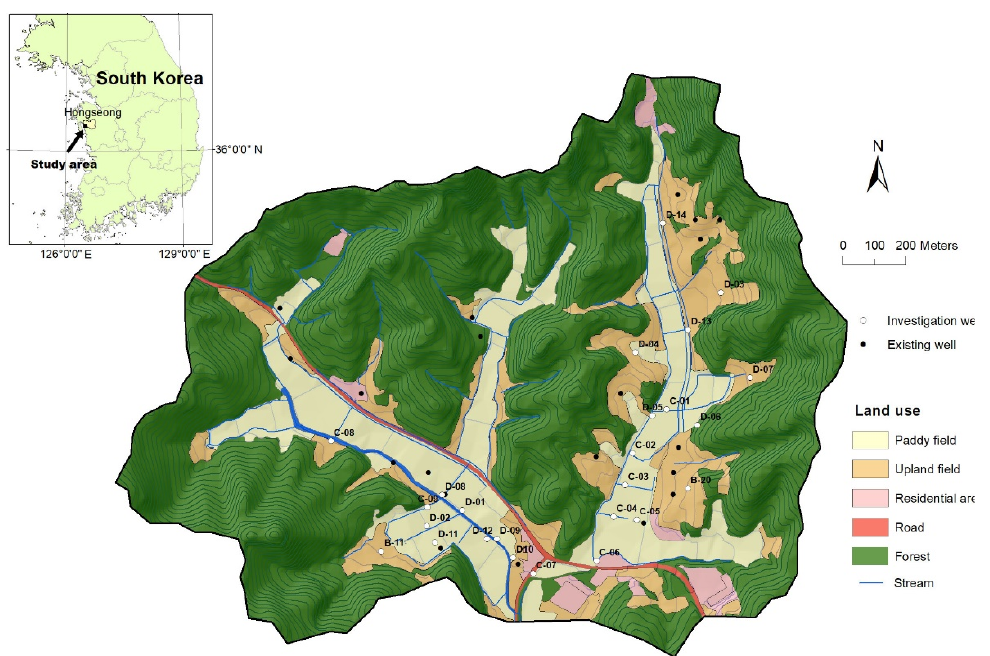
Figure 1. Study area and well locations.